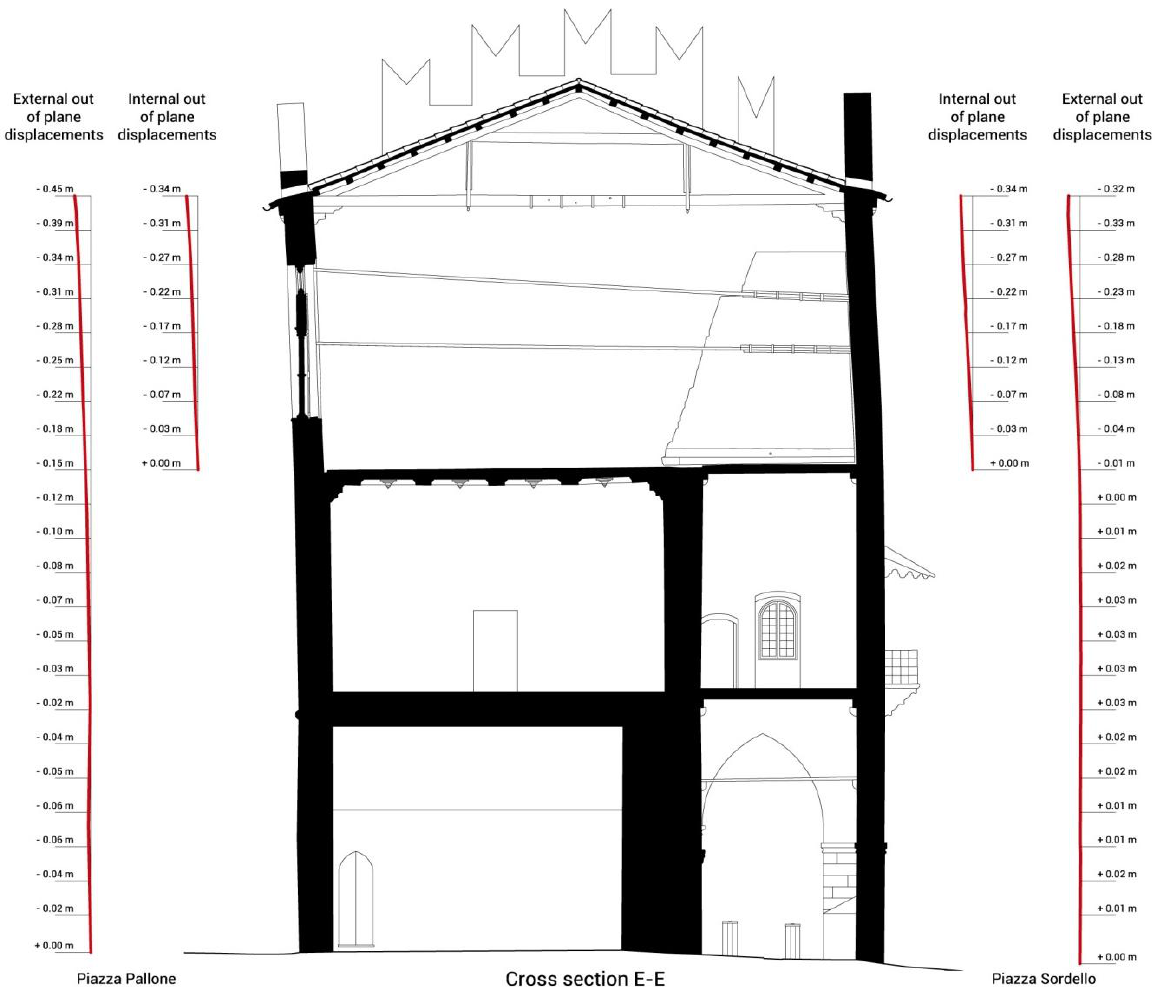
Figure 6. Cross section EE with the indication of the out of plane displacements of the walls as result by the Laser Scanner